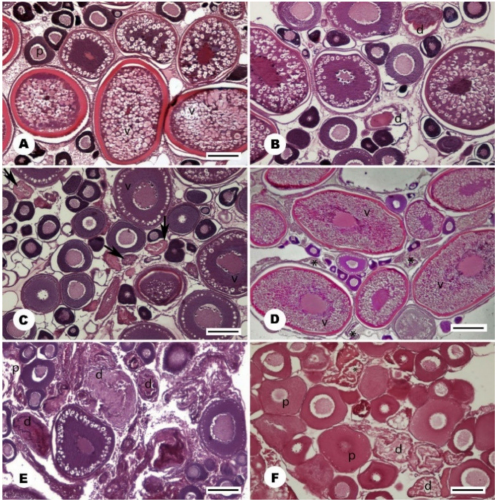
Figure 4. Histology of the gonad in the female stone moroko ( Pseudorasbora parva ) inhabiting War- dynka river, Poland. ( A ) a gonad with oocytes in the previtellogenesis (p) and vitellogenesis (v), February, bar 200 µ m; ( B ) with numerous degenerated oocytes (d), November, bar 100 µ m; ( C ) with oocytes at the beginning of vitellogenesis (v) and with degenerating oocytes at previtellogenesis (arrow), September, bar 150 µ m; ( D ) spawning gonads with oocytes in an advanced vitellogenesis (v), post-ovulatory follicles (asterisk) and the oocytes at the beginning of the next generation of pre- vitellogenesis, June, bar 200 µ m; ( E ) after spawning with the oocytes at the early previtellogenesis (p) and degenerated oocytes (d), July, bar 100 µ m; ( F ) with degenerating oocytes (d) in previtellogenesis (p) and post-ovulatory follicles (asterisk), end of July, bar 100 µ